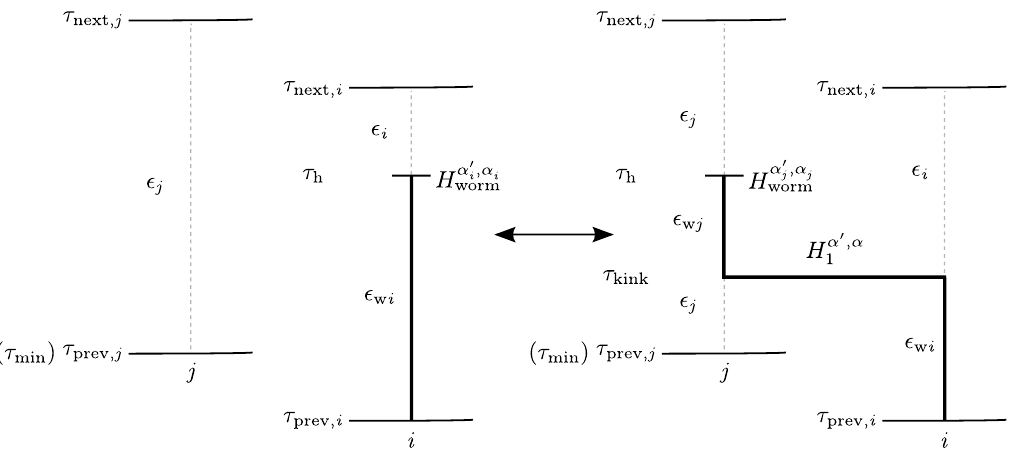
Figure 17: Insert / Delete kink before head. A kink is inserted between neighboring sites i , j before the worm head at a randomly sampled time τ the head moved to the site where the particle hops to. The lower bound of the sampling interval τ is chosen to be the largest out of the two lower bounds of the min corresponding flat intervals. This ensures that the new kink does not interfere with other kinks, which simplifies the implementation. The complementary update is to delete the kink and move the head back to the site from where the particle is hopping